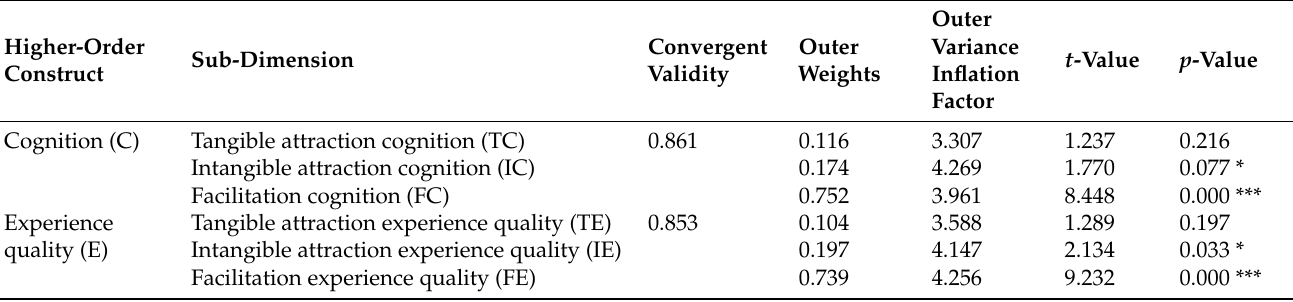
Table 9. Assessment of higher-order